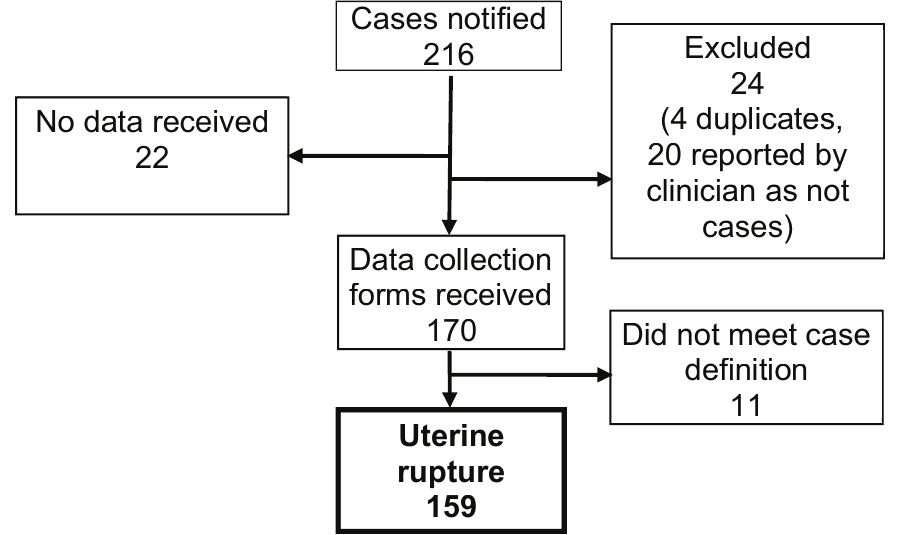
Figure 1. Case reporting and completeness of data collection.